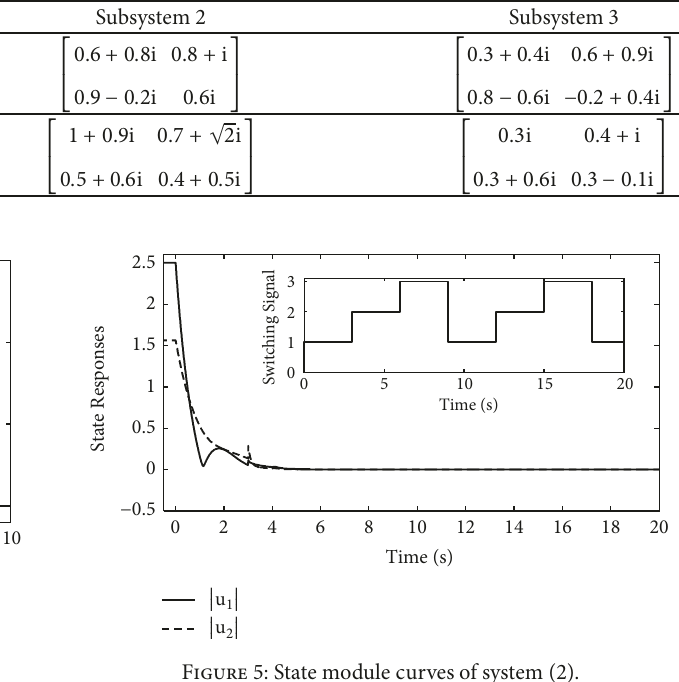
Figure 3: State curves of subsystem 3 in (2).